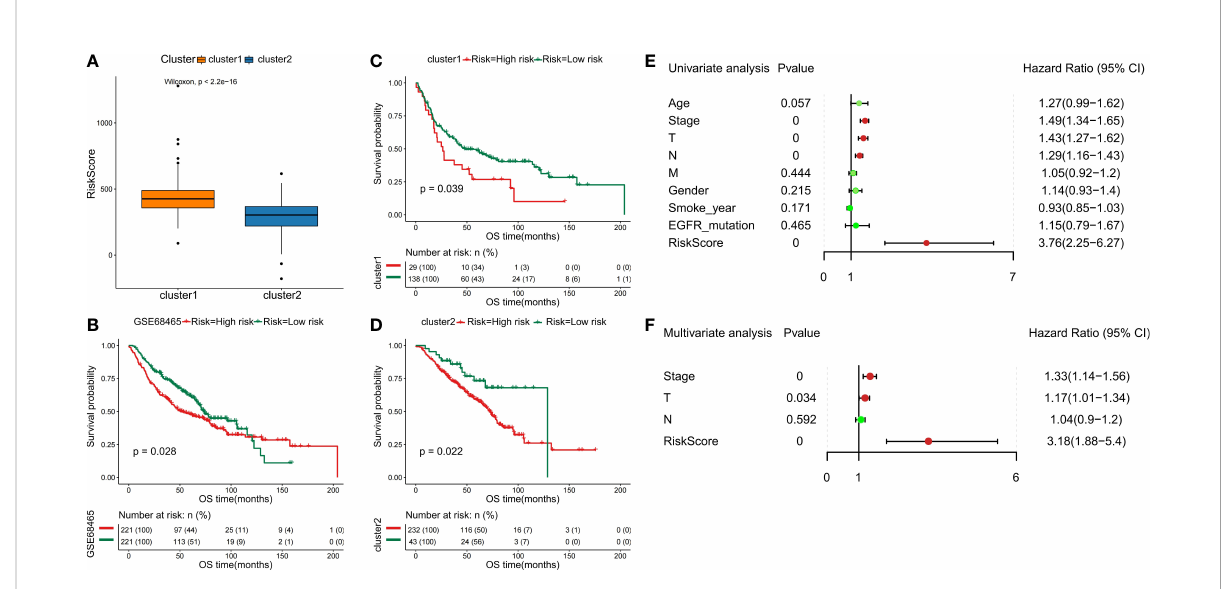
FIGURE 8 Validation of six DDR-related signatures by the LASSO regression model. (A) Distribution of risk scores in NSCLC subclasses. (B - D) Kaplan- Meier OS analysis of the prognostic DDR-related signature in NSCLC and NSCLC subtypes. (E) Evaluation of the prognostic values for different clinicopathological characteristics (age, smoking_year, gender, stage, T staging, N staging, M staging, and EGFR_mutation) as well as a risk score using univariate Cox regression analysis. (F) Multivariate Cox regression analysis was used to test the independence of the risk score and other factors for predicting the prognosis of